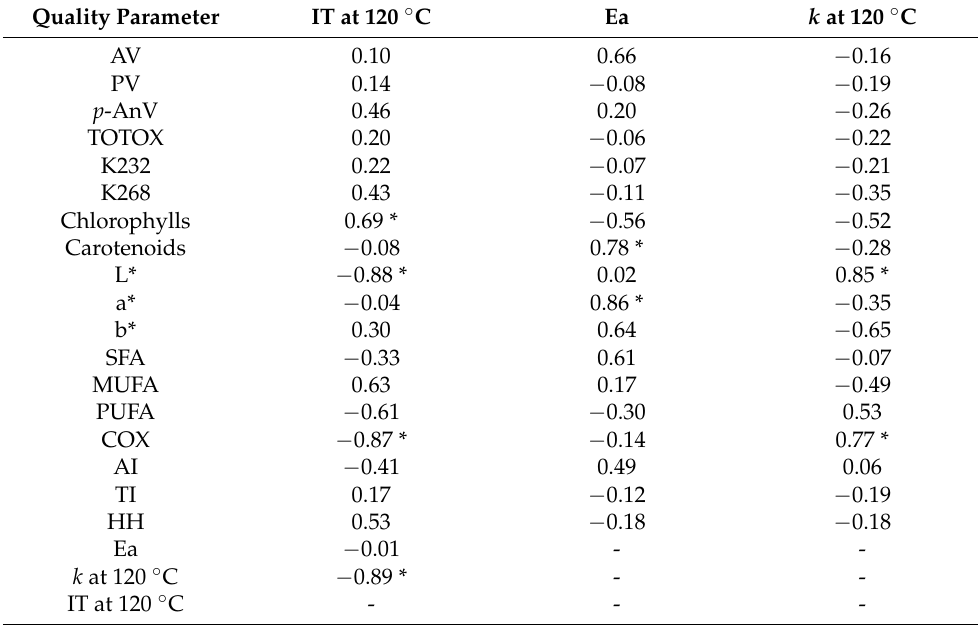
Table 6. Correlation coefficients between the oxidation parameters and the quality parameters of the tested